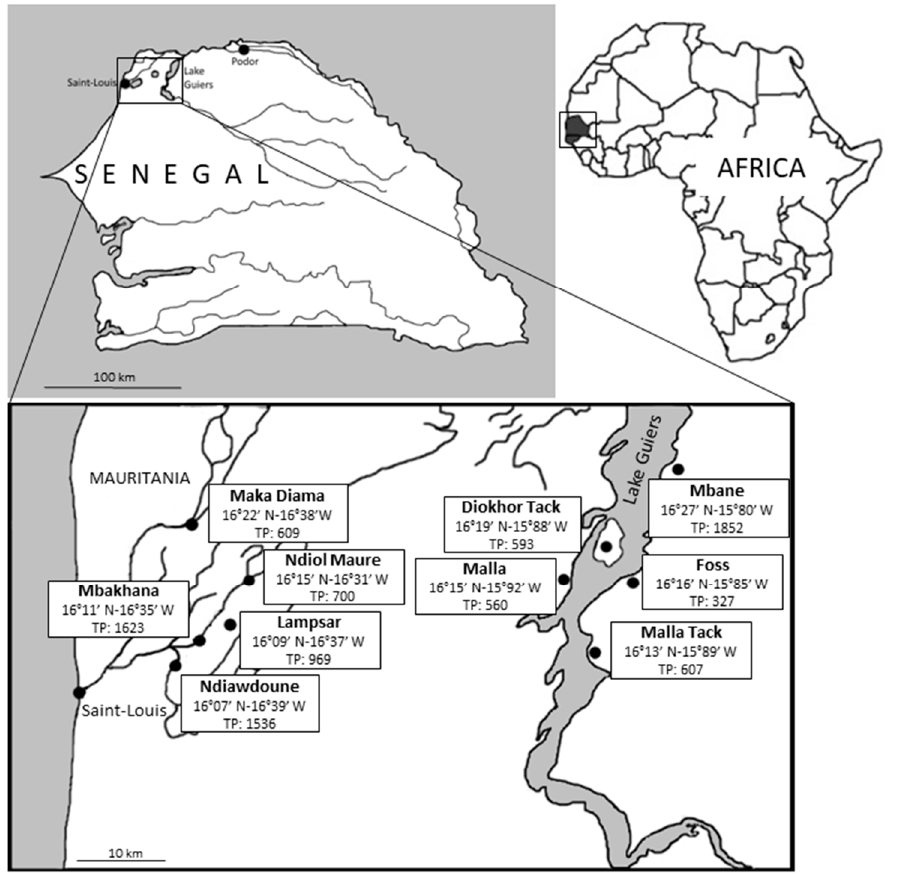
Figure 1. Detailed location of the 10 villages in Northwestern Senegal screened for the presence of Blastocystis sp. by qPCR. Geographic coordinates and total population (TP) of each of the villages are indicated.